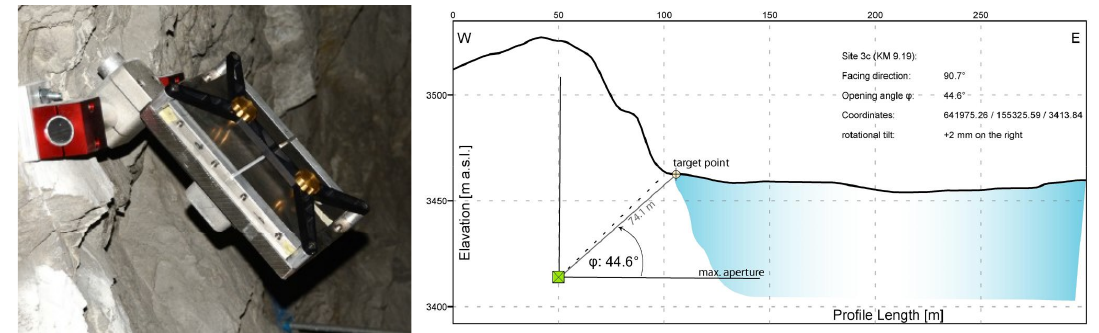
Figure 6. Detector frames installed at the rock wall in the railway tunnel ( left ). Cross-sectional topography with the detector D3 shown in green ( right ).